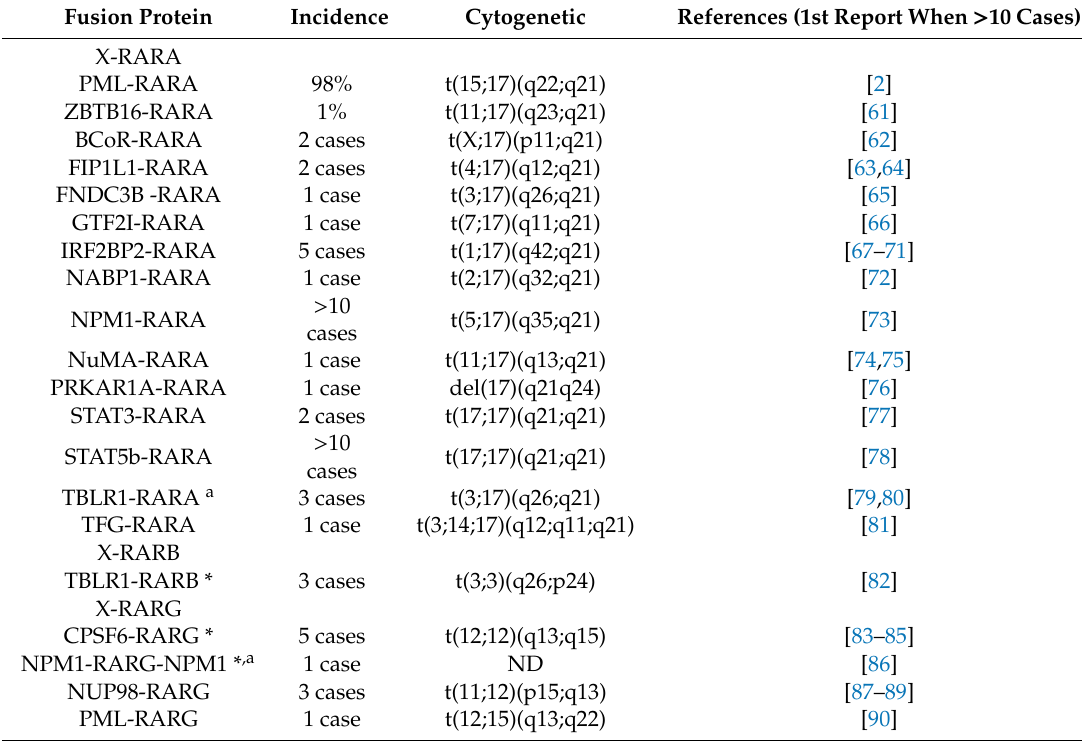
Table 1. RAR partners causing APL and APL-like